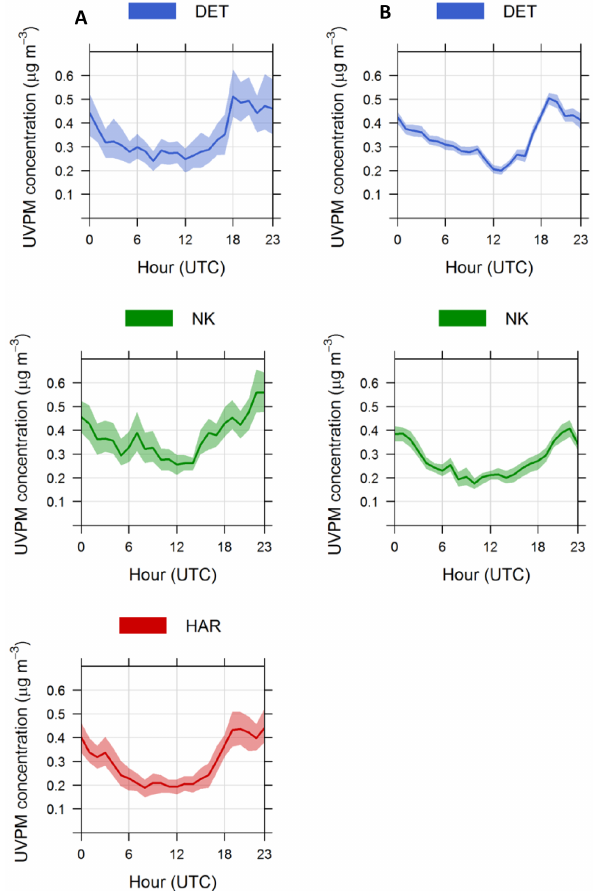
Figure 6. Mean diurnal cycles of UVPM during the winter cam- paign as determined by 2W AEs (column A) and 7W AEs (column B) for the sites where the data were available. Shaded areas indicate the 95% confidence intervals. In the key, HAR and DET represents Harwell and Detling respectively.